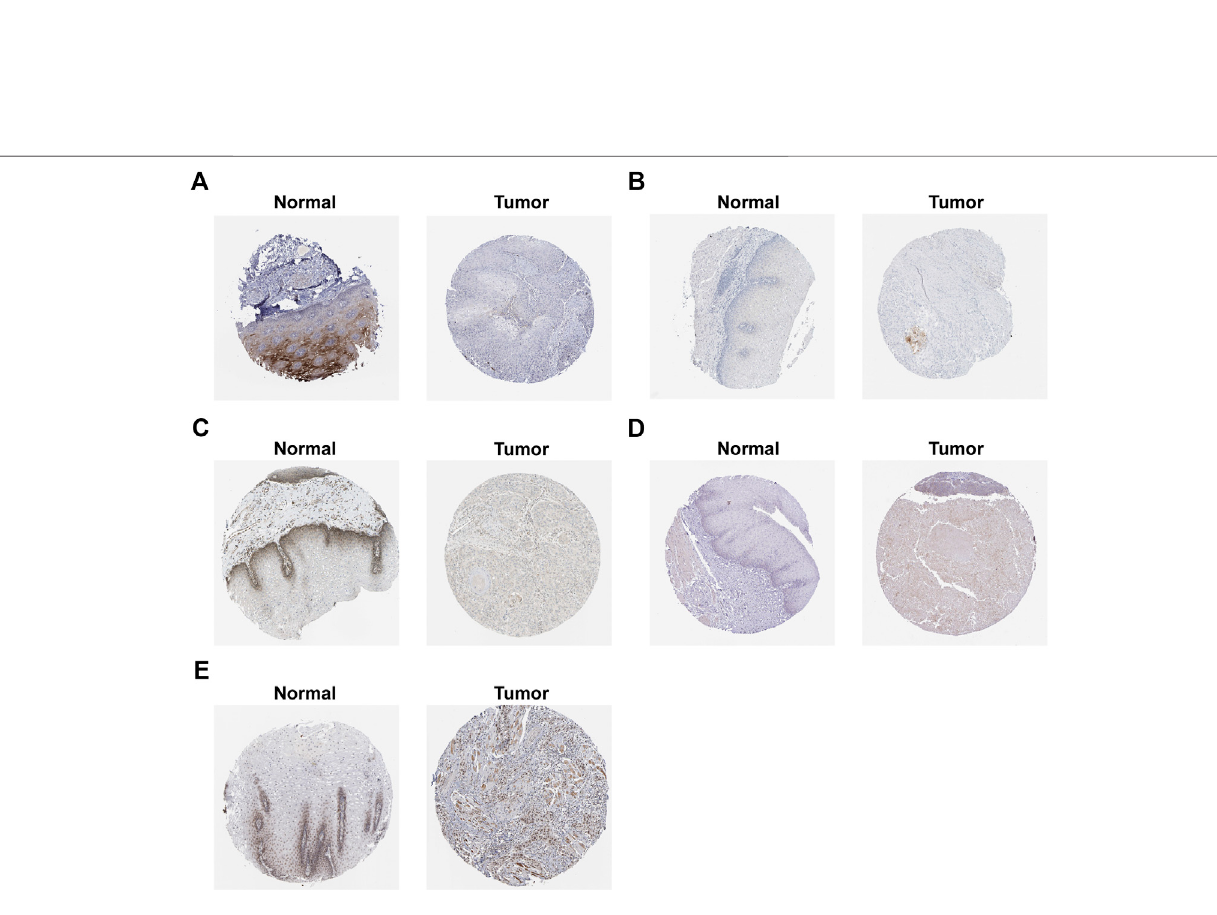
Frontiers in Molecular Biosciences |